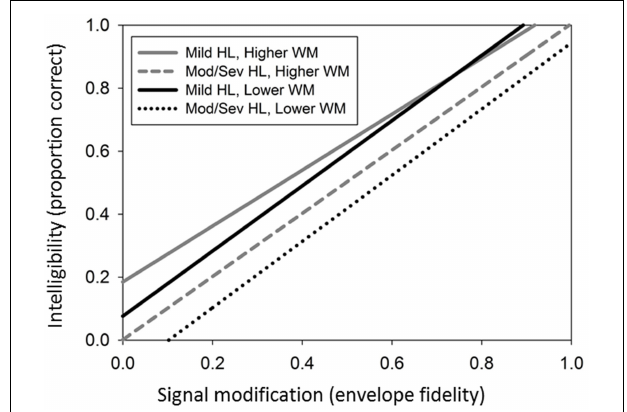
FIGURE 6 | Final model for intelligibility, showing four different fitted trajectories of intelligibility as a function of envelope fidelity for hearing loss (HL) and working memory (WM).